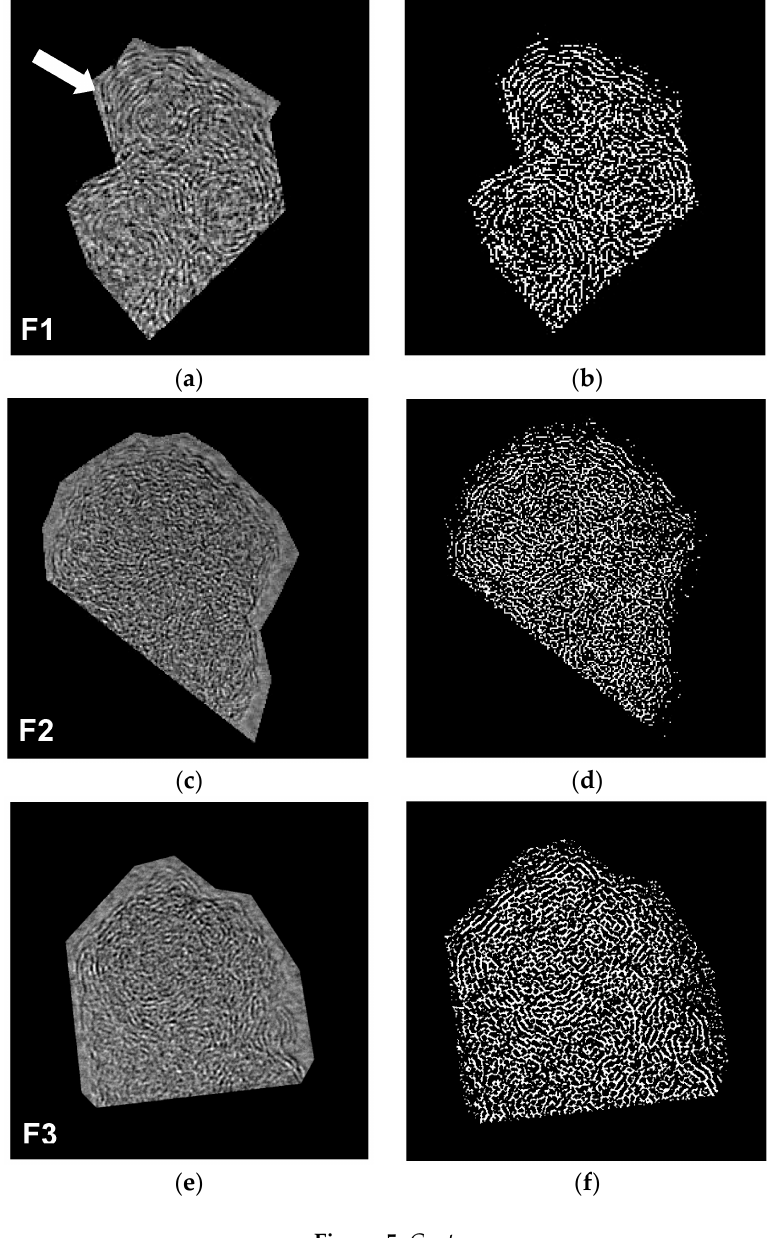
Figure 4. Distribution map of separation distances of nascent soot particles under different conditions: ( a ) pure ethylene; ( b ) 1-pentanol/ethylene; ( c ) 3-methyl-1-butanol/ethylene; ( d ) 2-methyl-1-butanol/